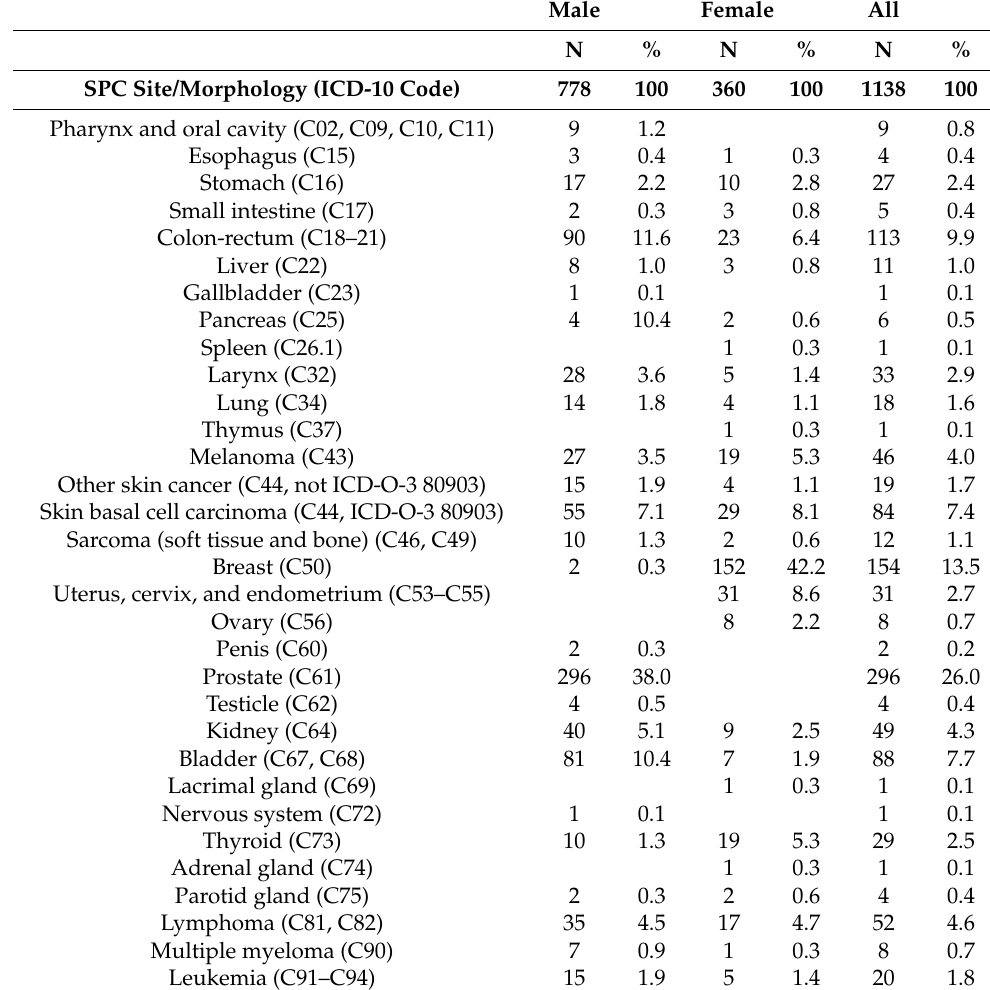
Table 2. Distribution of second primary cancer (SPC) overall and by gender, Lombardy,